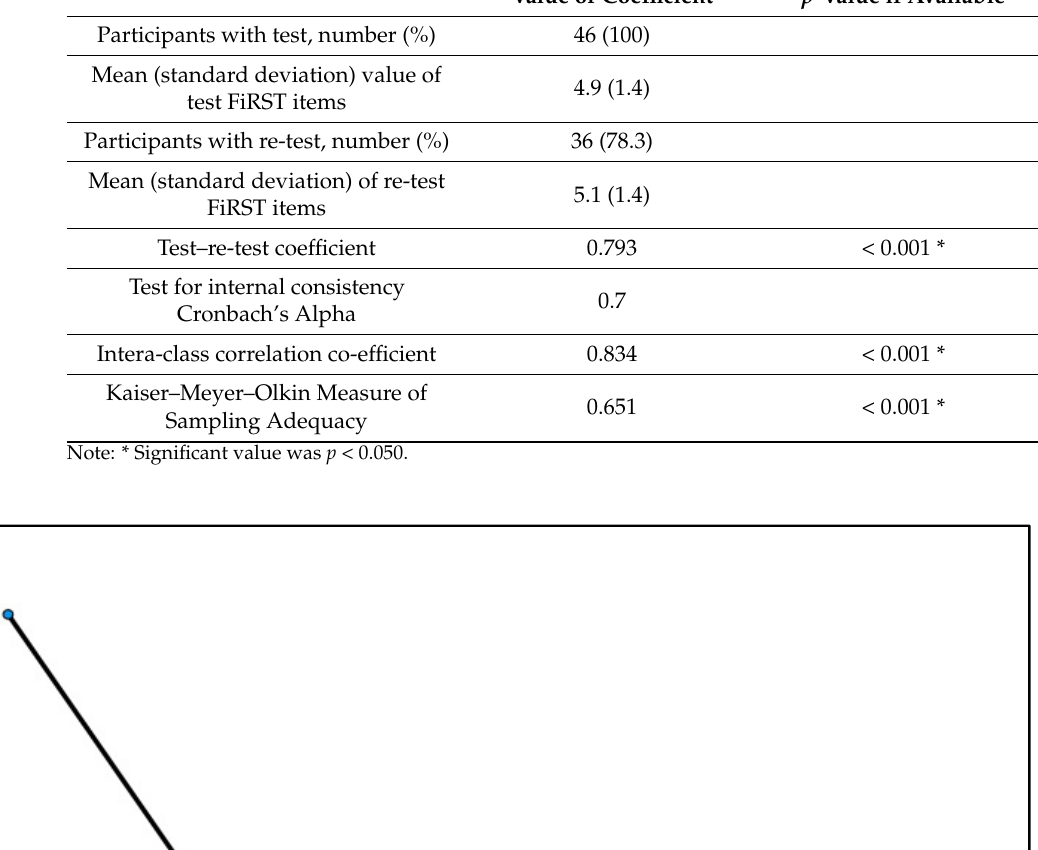
Table 2. Psychometric properties of the survey items.